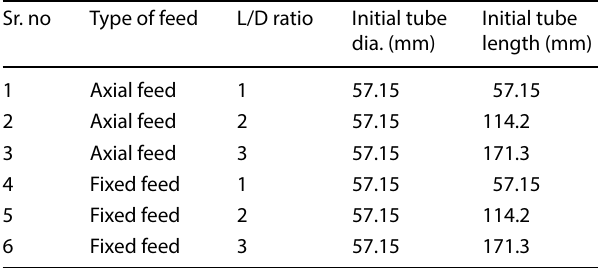
Table 7 Tube preparation for experimentation